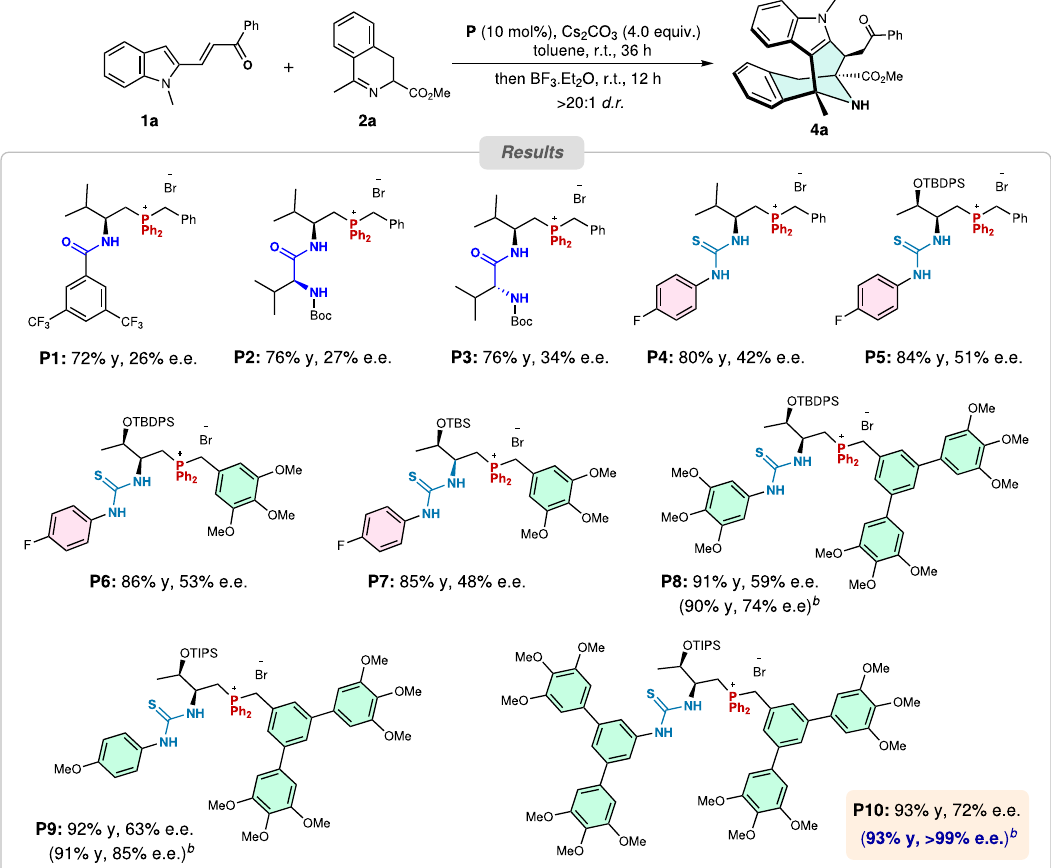
Fig. 3 Selected optimization studies on bifunctional chiral phosphonium salts. a Reaction condition: substrates 1a (0.10 mmol) and 2a (0.12 mmol) in the presence of P (0.01 mmol) and Cs 2 CO 3 (0.40 mmol) in toluene (2.0 mL) at r.t. for 36 h; then BF 3 ·Et 2 O (1.0 mmol) was directly added to the reaction mixture which was further stirred at r.t. for 12 h. b Optimal conditions: the reaction was performed with 6.0 equiv. of Cs 2 CO 3 in Et 2 O at − 20 °C for 72 h; and then BF 3 .Et 2 O was directly added at r.t. for further stirring 12 h (see the SI for more